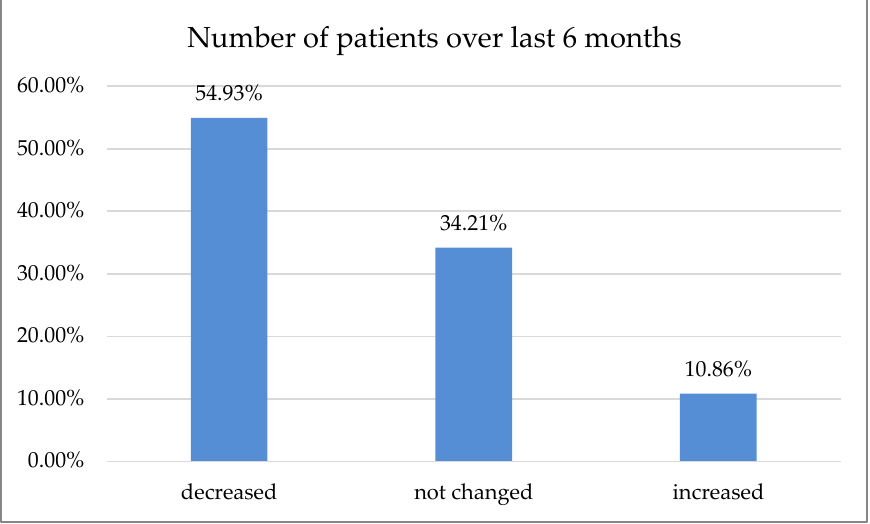
Over 50% of the respondents declared thatthe number of patients decreased over the last six months (Figure 3). last six months (Figure 2); 70.72% of respondents reported an increase in prices over the last six months (Figure 3). last six months (Figure 3).